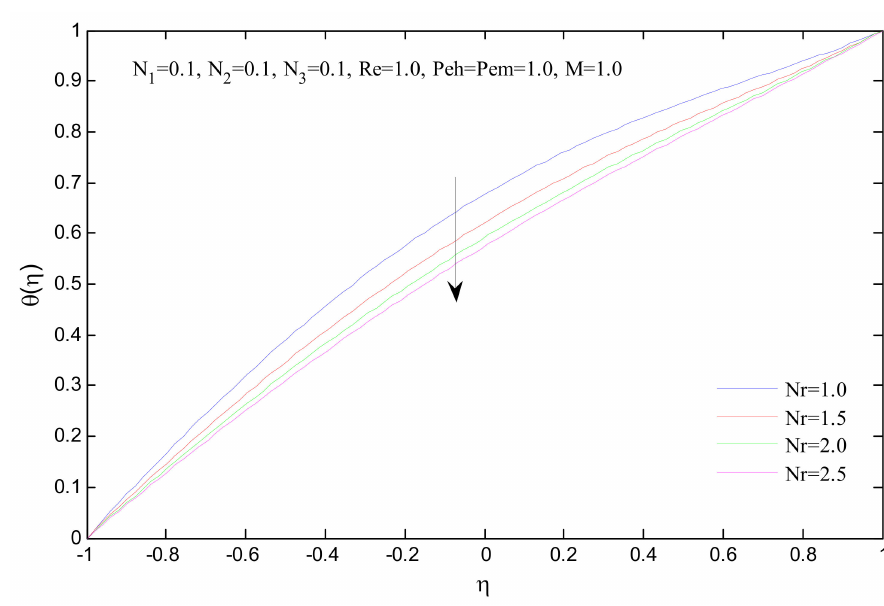
Figure 10. Effect of Re on microrotation profile.